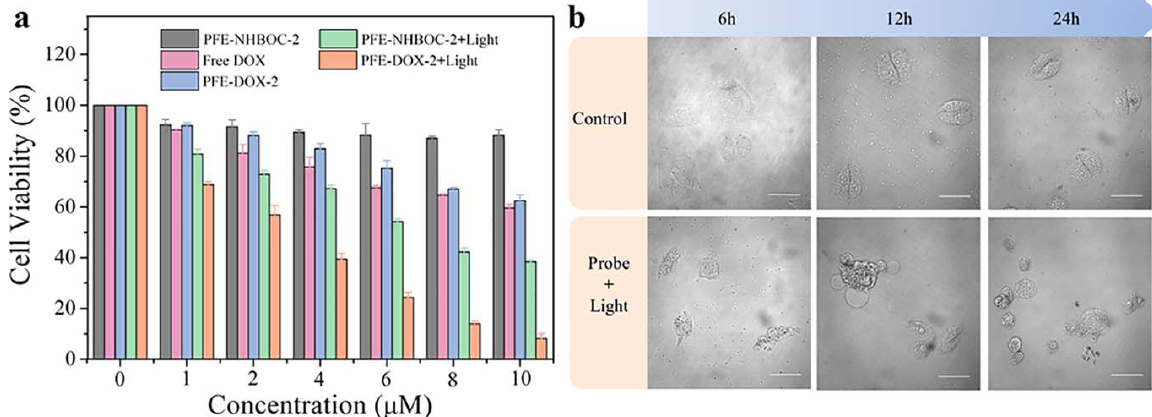
Figure 6. ( a ) Cytotoxicity of PFE-NHBOC-2, PFE-DOX-2 and free DOX against MCF-7 cells without or with light irradiation (25 mW cm − 2 ) for 30 min. ( b ) The morphological changes in MCF-7 cells incubated with PFE-DOX-2 and treated with light irradiation over time. Scale bar is 40 µ m. After white-light irradiation (25 mW cm − 2 , 30 min), PFE-NHBOC-2 displayed sig- nificant cytotoxicity against MCF-7 cells, and cell viability was reduced to 38% when